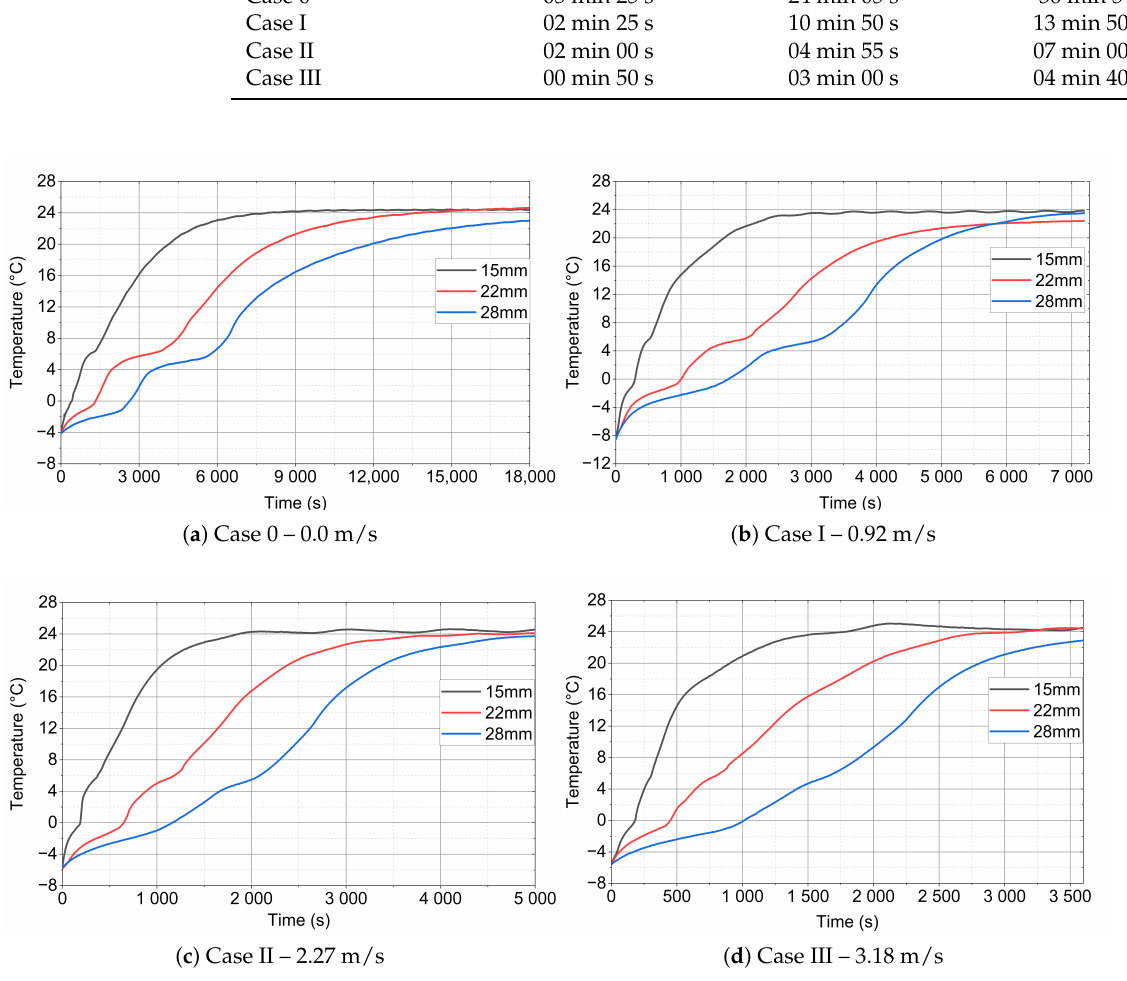
Figure 12. T 3 thermocouple evolution for different diameter of PCM module and velocity: ( a ) Case 0–0.0 m/s, ( b ) Case I– 0.92 m/s, ( c ) Case II–2.27 m/s, and ( d ) Case III–3.18